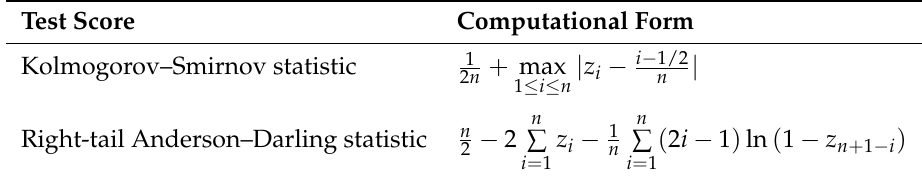
Table 2. Goodness-of-fit test scores used in this study and their computational form. Note that z i = F ( x i ) , where F ( x ) is the theoretical cumulative distribution function and x = { x 1 , . . . , x n } is the observed